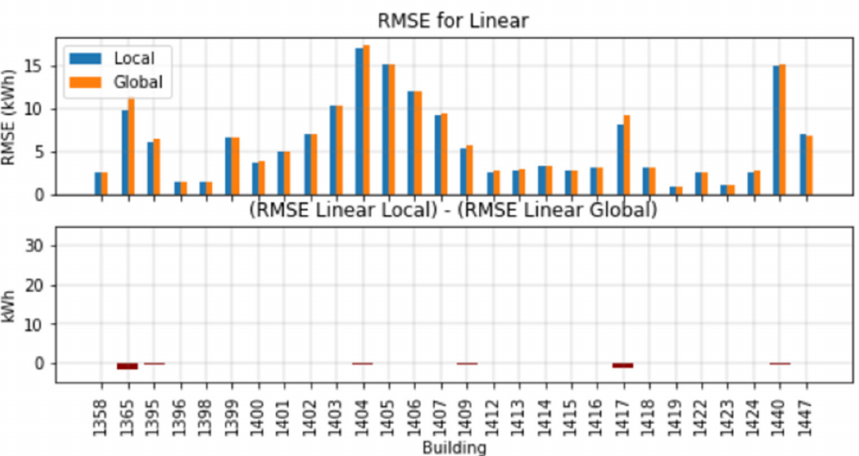
Figure 4. The upper figure shows the comparison between the RMSE obtained from the local and global Linear models on test set. The lower figure contains the difference between the RMSE obtained for the local and global Linear models on test set.